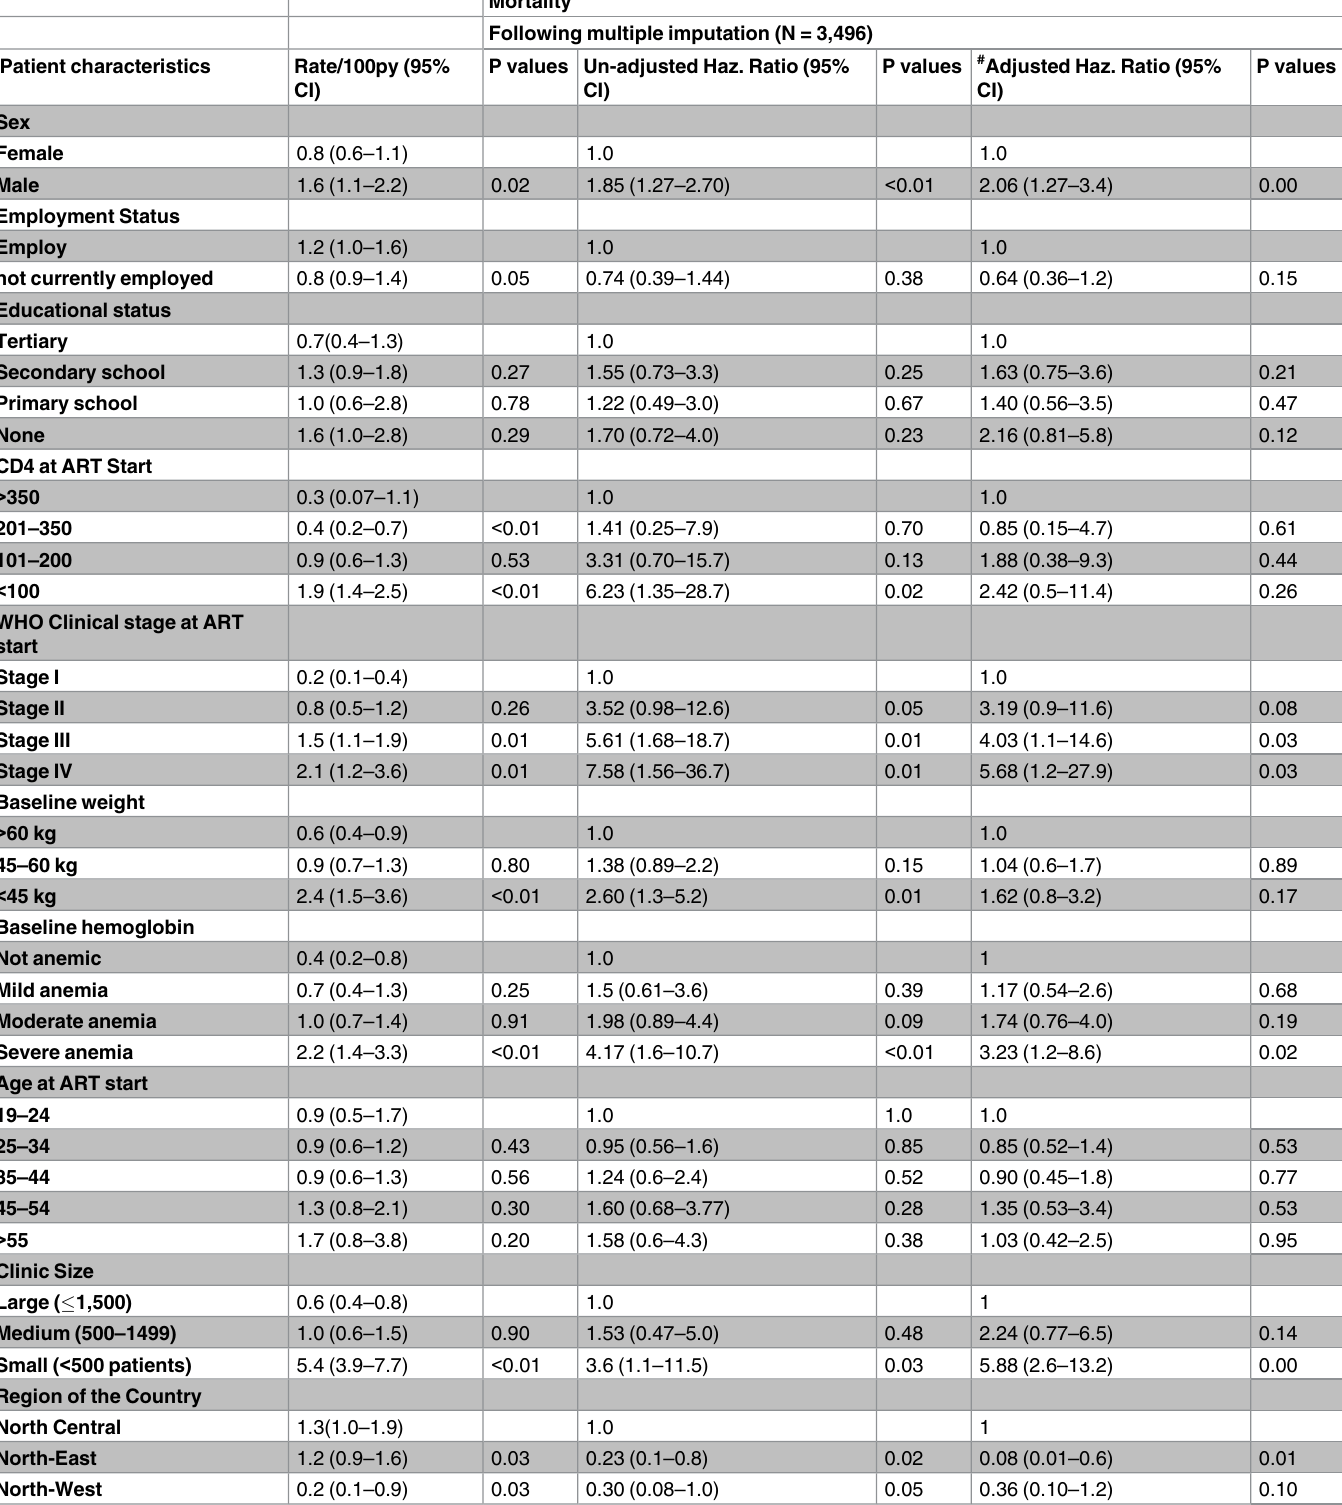
Table 4. Patient characteristics at antiretroviral therapy initiation associated with Mortality.